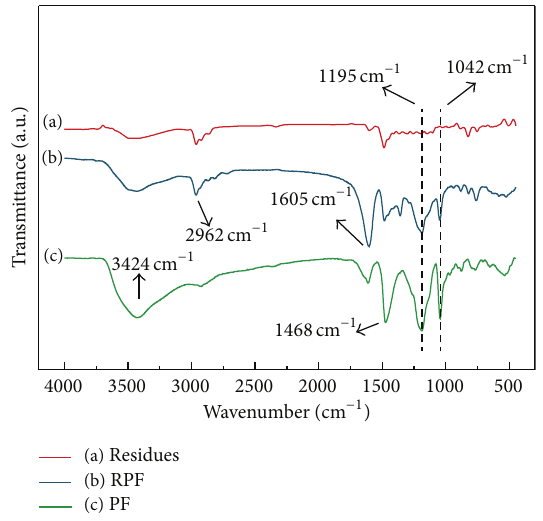
Figure 4: FTIR spectra of the residues, RPF, and PF.